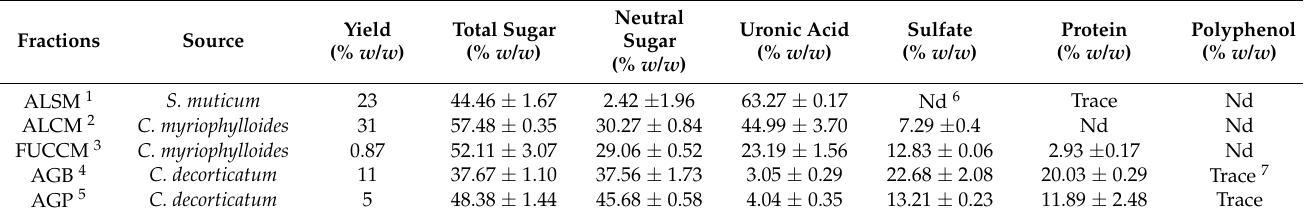
Table 1. Biochemical characterization and extraction yield of polysaccharides extracted from CE, SM, and